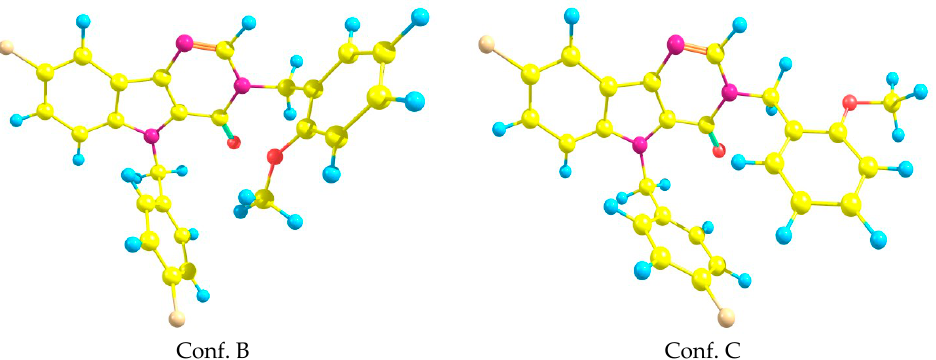
Figure 7. Two additional conformations of the title system ( 3 ).